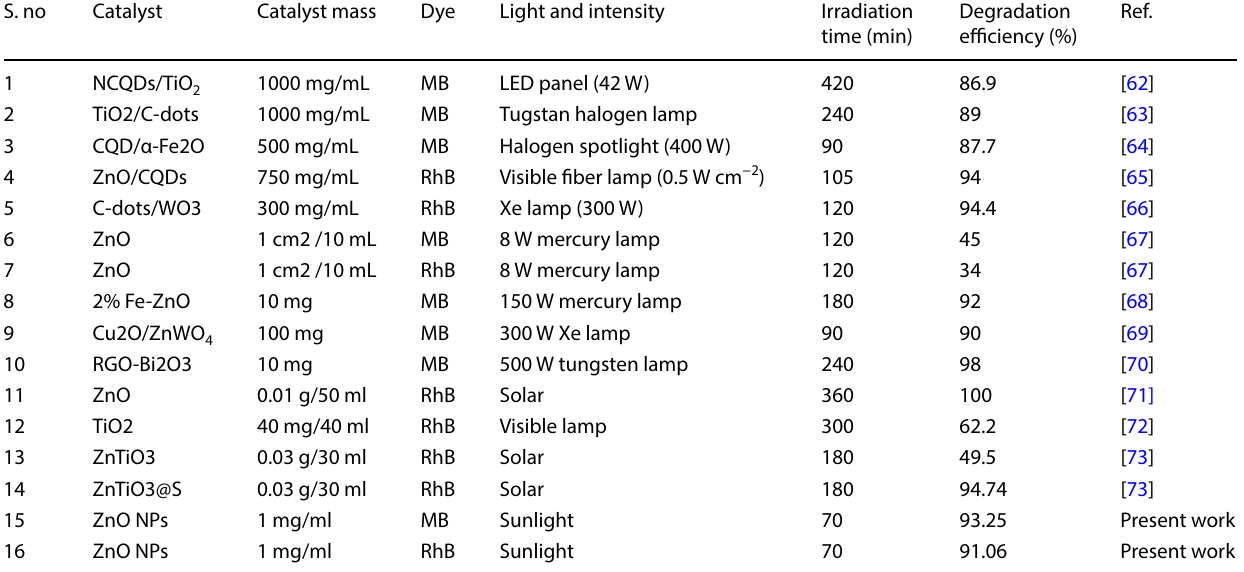
Table 1 Previous work done in the literature S.